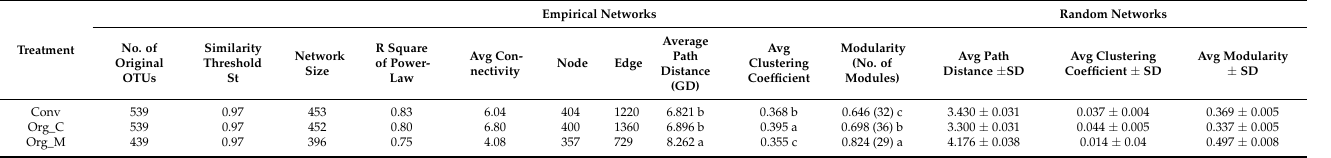
Table 1. Topological properties of the empirical pMENs of microbial communities of the three cropping systems and their associated random